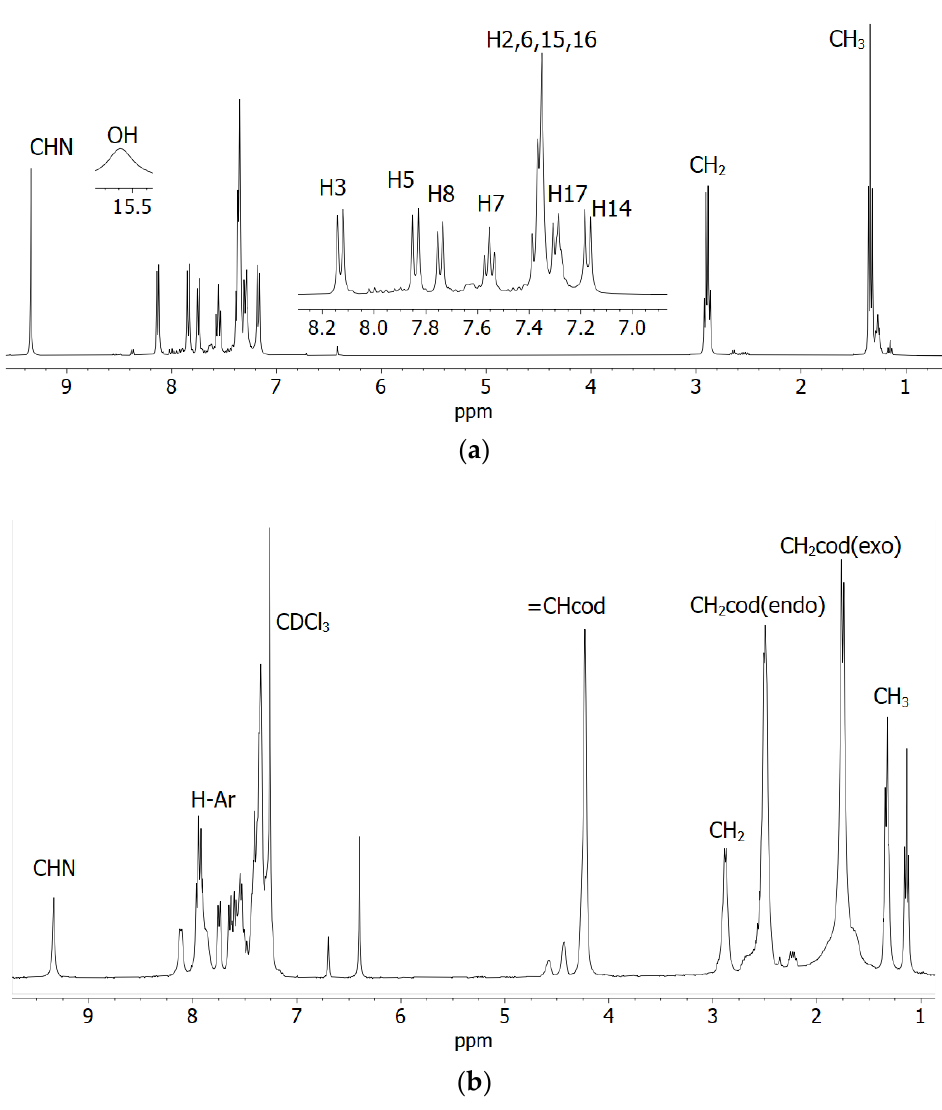
Figure 1. 1 H NMR spectra of the Schiff base ( a ) HL 2 with hydrogen atoms numbered and ( b ) com- pound 2 in CDCl 3 at 20 °C.